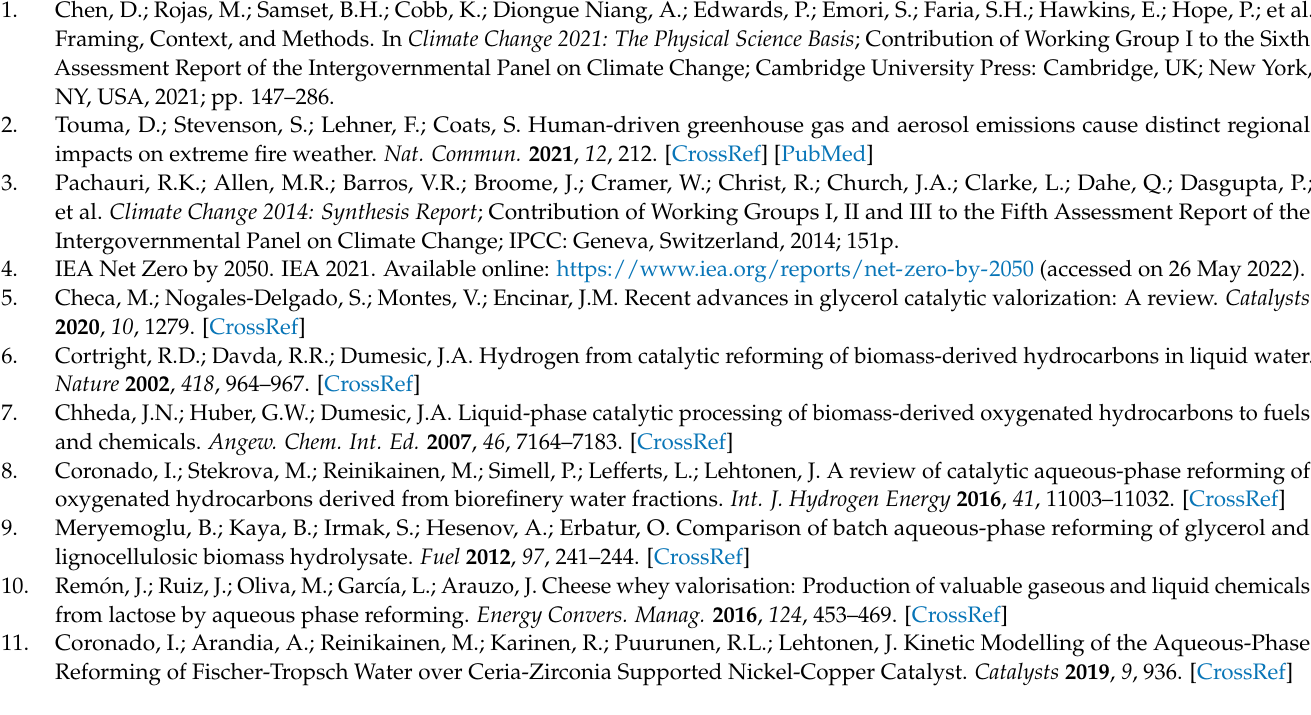
Figure S2. Variation of reaction indices with TOS; Figure S3. Reduction profiles of used catalysts in aqueous-phase reaction for 3 h; Figure S4. TPR-MS of used catalysts in aqueous-phase reaction for 3 h; Table S1. Parameters of mass transfer limitations for supported (NiAl/SBA-15) and nanocasted catalysts; Table S2. Comparison with other works in the literature